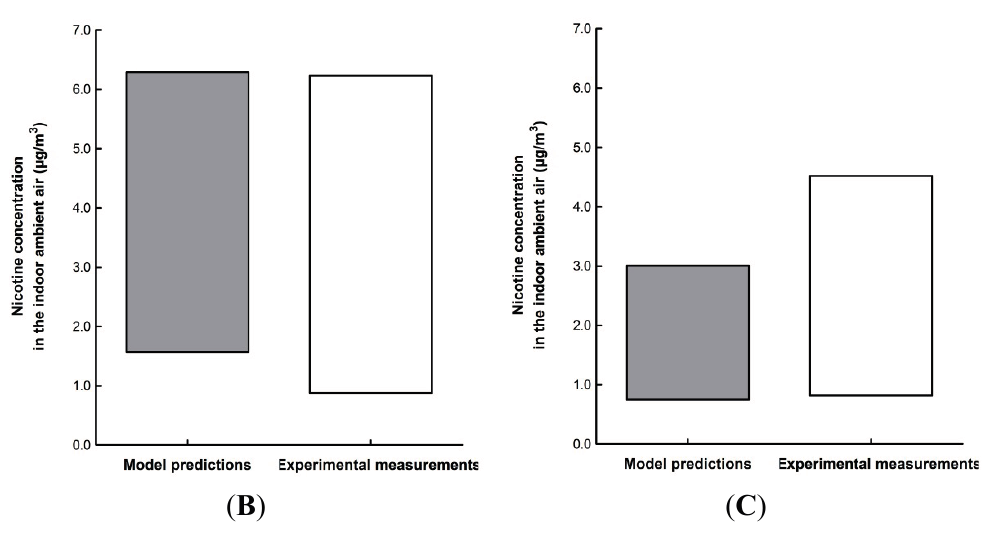
Figure 3. Estimation of the nicotine concentration in the indoor ambient air using experimentally-derived model input parameters. ( A ) Simulated change in